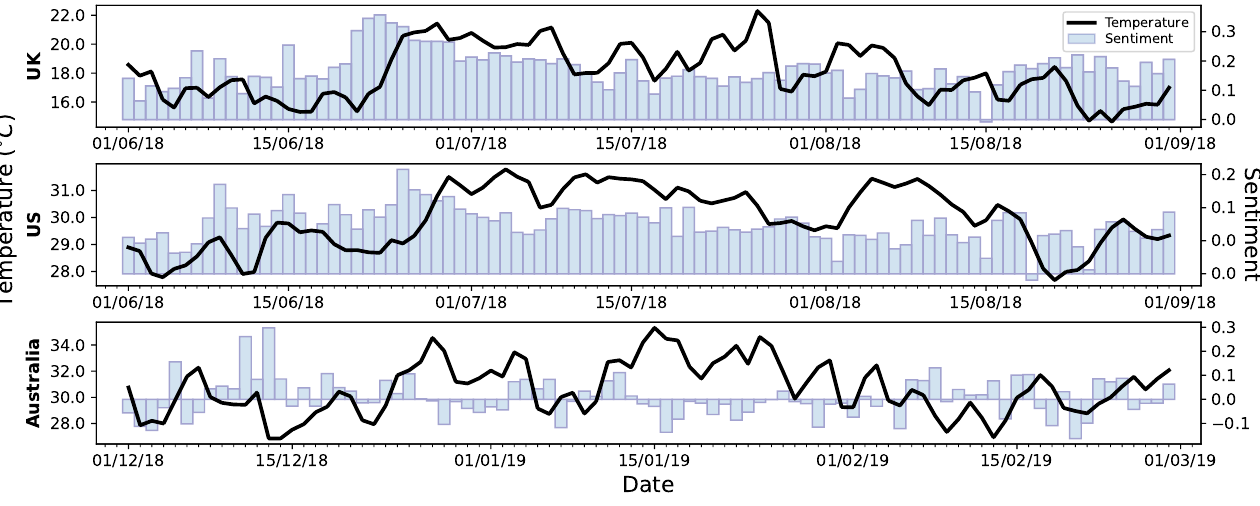
Figure 3. Bar chart of sentiment change throughout the summer months from tweets within each country, with ADMT plotted in